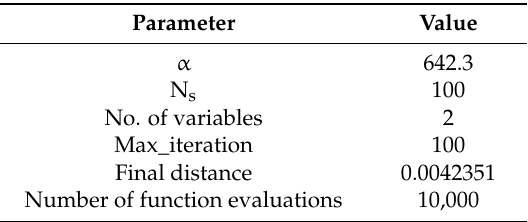
Table 1. Optimal mine blast algorithm controlling parameters.